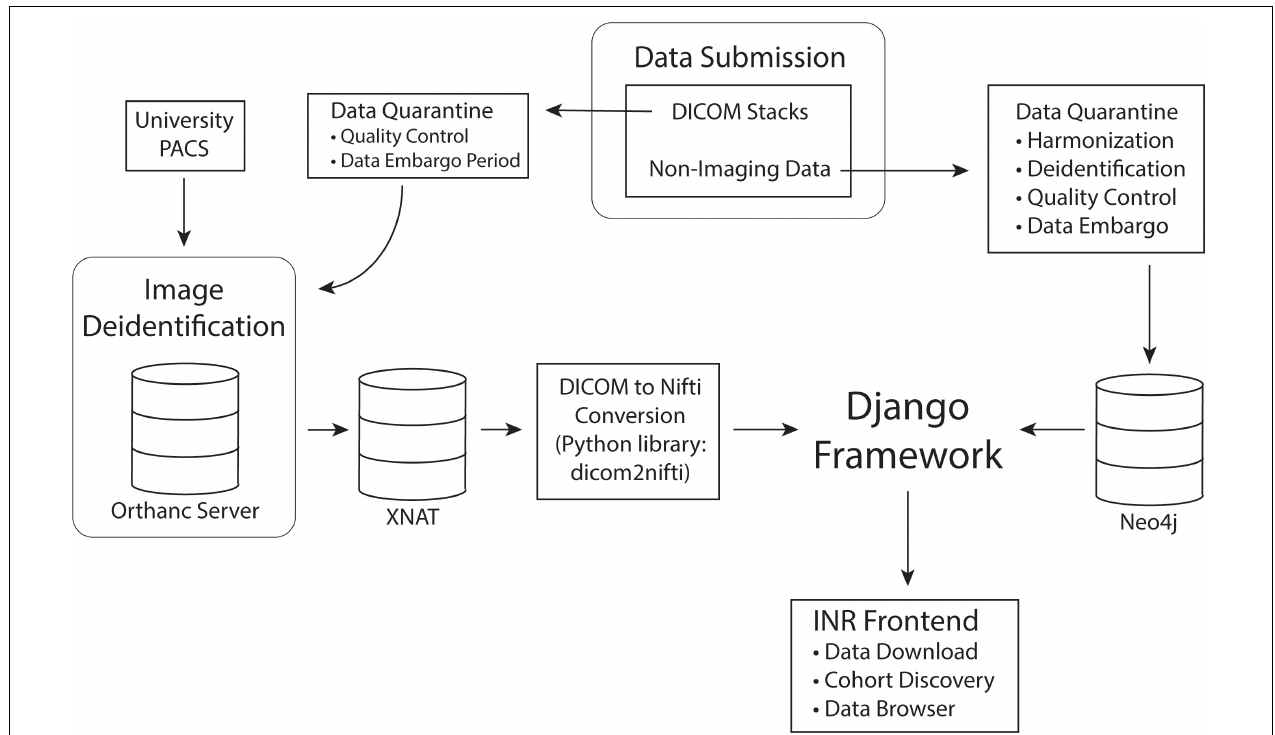
FIGURE 2 | Data processing pipeline. Data is first submitted through the INR website and separated into imaging and non-imaging data. All data is quarantined for quality control and harmonization. If the contributing investigators wish to embargo their data for primary publication rights, the data will remain in quarantine for the length of the embargo period. While in quarantine, data will be thoroughly deidentified. After quarantine, imaging data will be permanently stored in XNAT and non-imaging data in Neo4j. Finally, the Django framework will connect the data to the INR frontend for queries and data exploration.